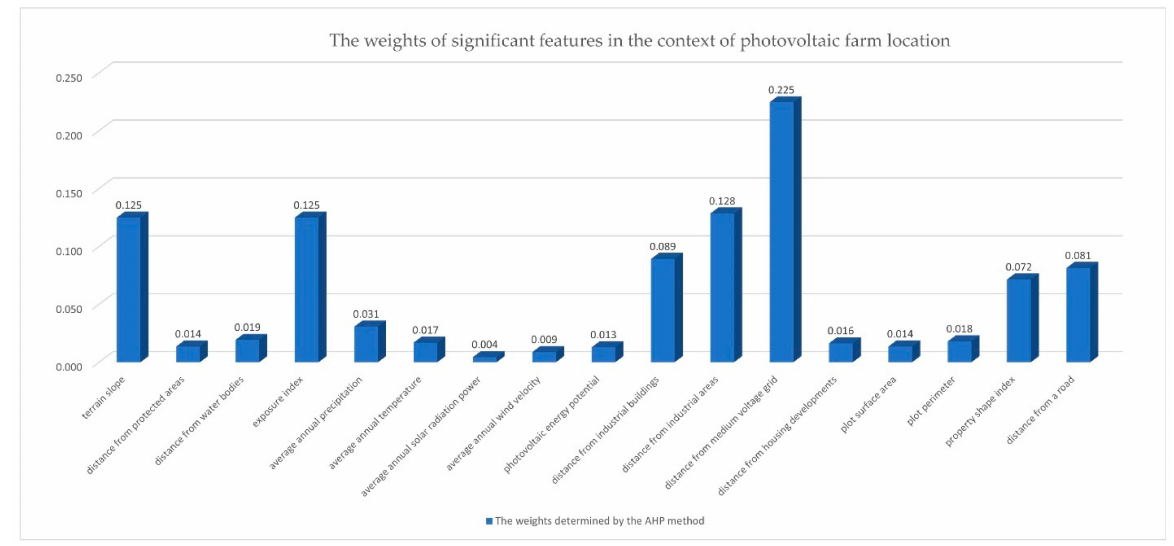
Figure 8. The weights of significant features in the context of photovoltaic farm location, determined by the AHP